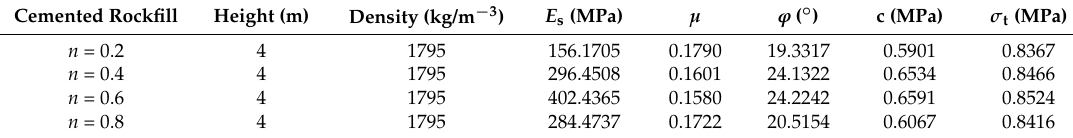
Table 7. Model parameters of the cemented rockfill with different granule gradations.